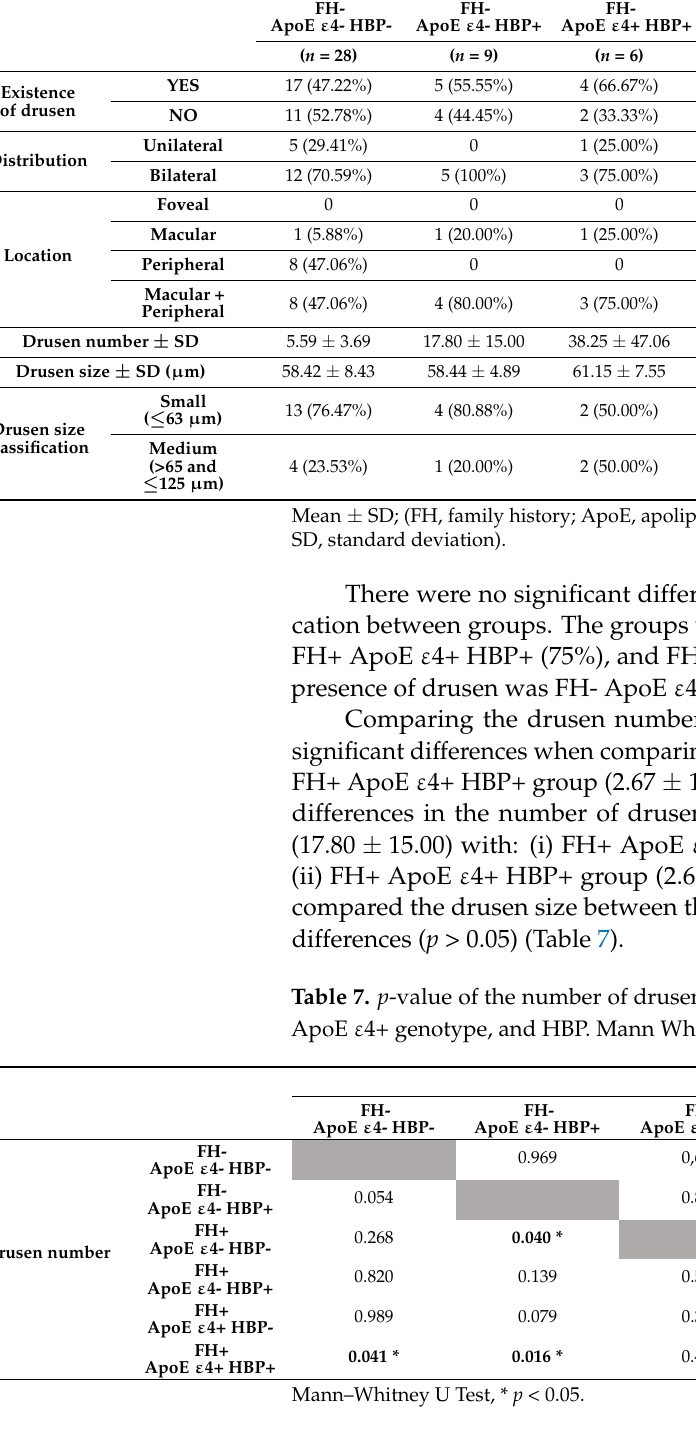
Table 6. Characterization of drusen by FH, ApoE genotype, and HBP. FH- ApoE ε 4- HBP-